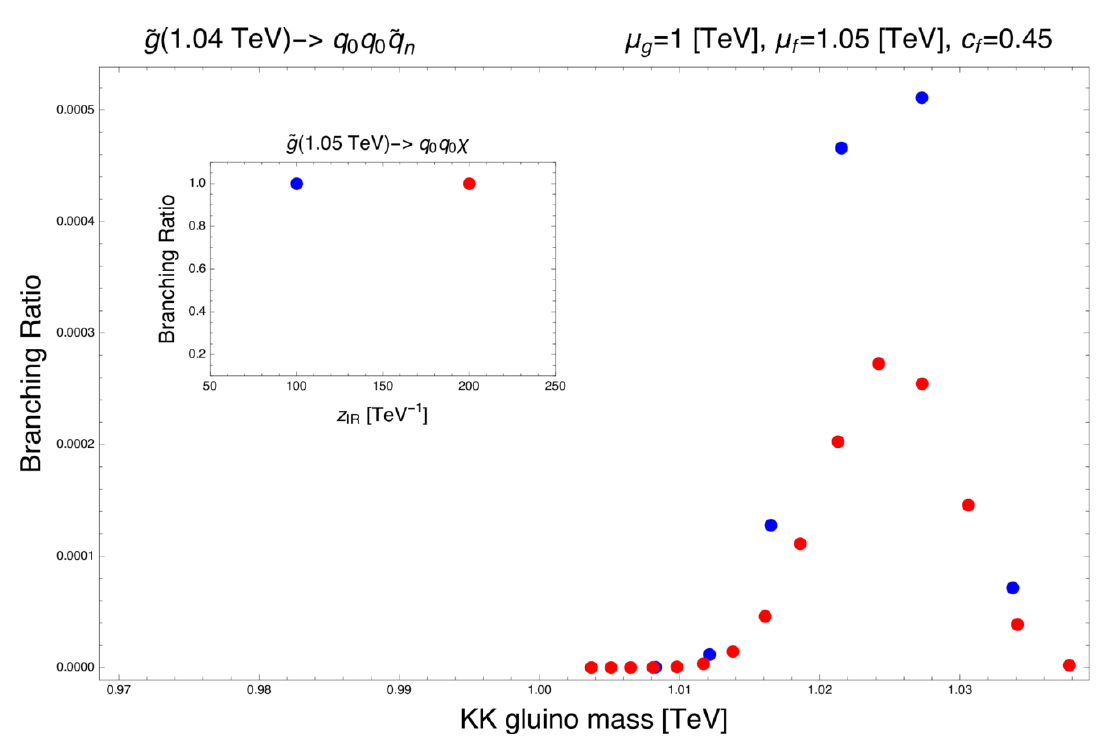
Figure 14. Examples of decay probabilities of a KK gluino with mass < (cid:22) f for di(cid:11)erent choices of z IR : 0.1 GeV (cid:0) 1 (blue), and 0.2 GeV (cid:0) 1 (red). The small graph shows the probability of its decay to LSP, which is assumed to be massless.